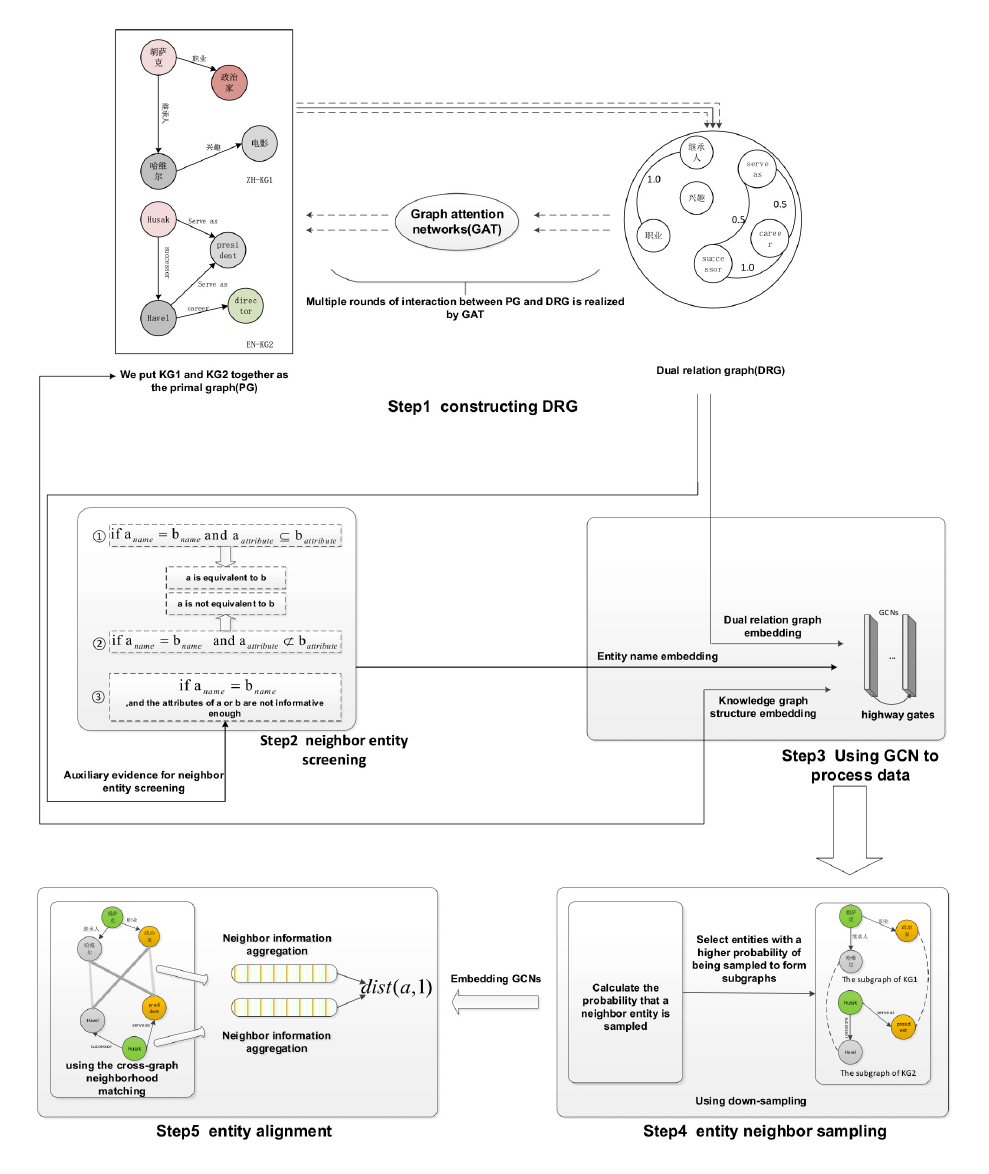
Figure 4. Method overview. ZH-KG1 and EN-KG2 represent the Chinese knowledge graph and English knowledge graph,